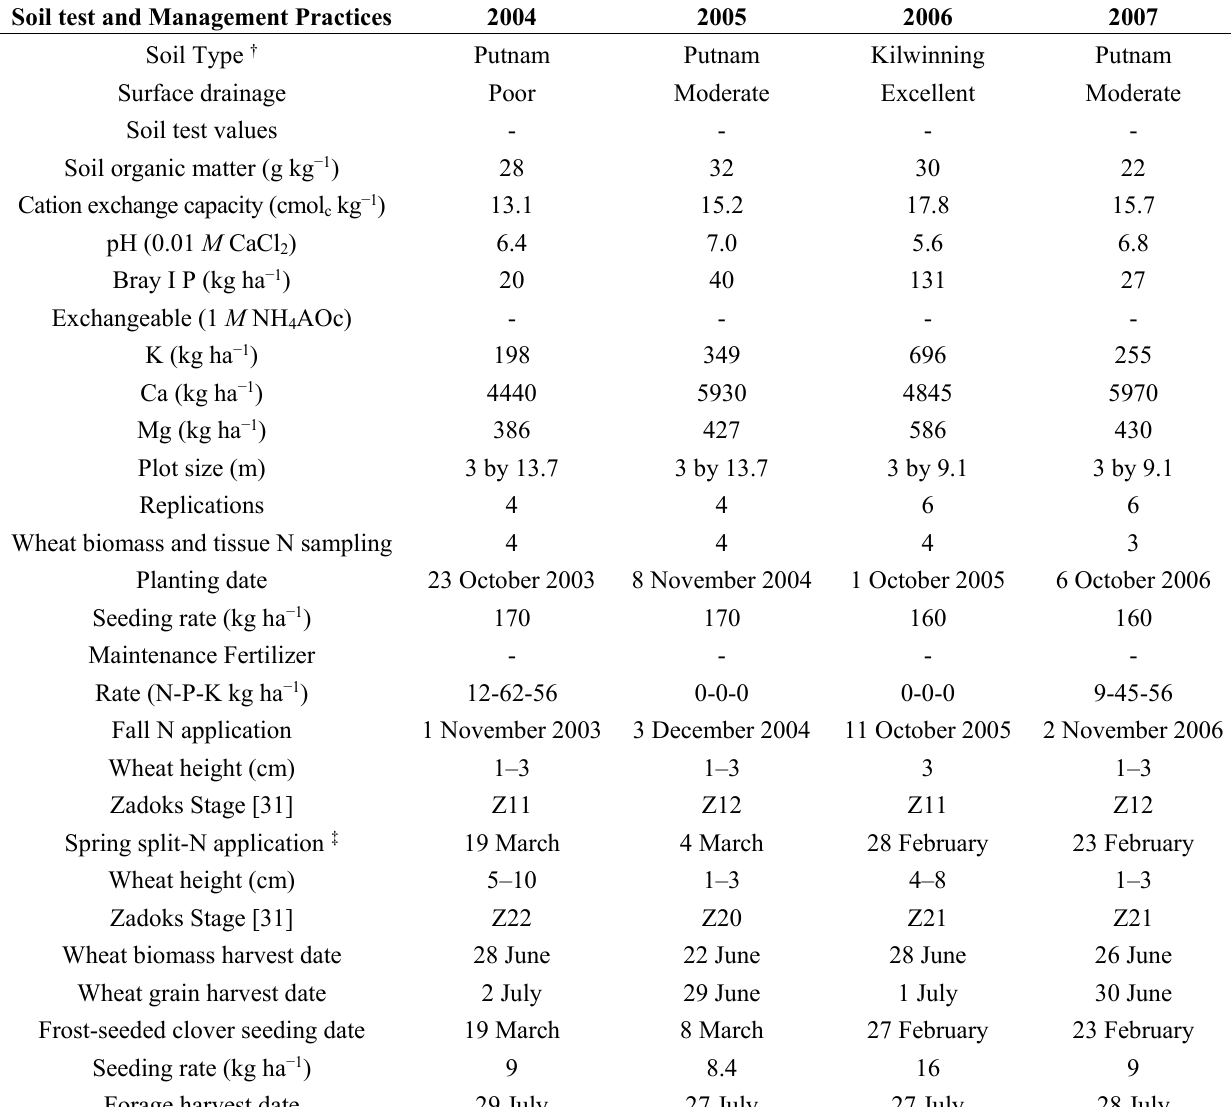
Table 1. Soil test values and wheat management practices in 2004, 2005, 2006, and